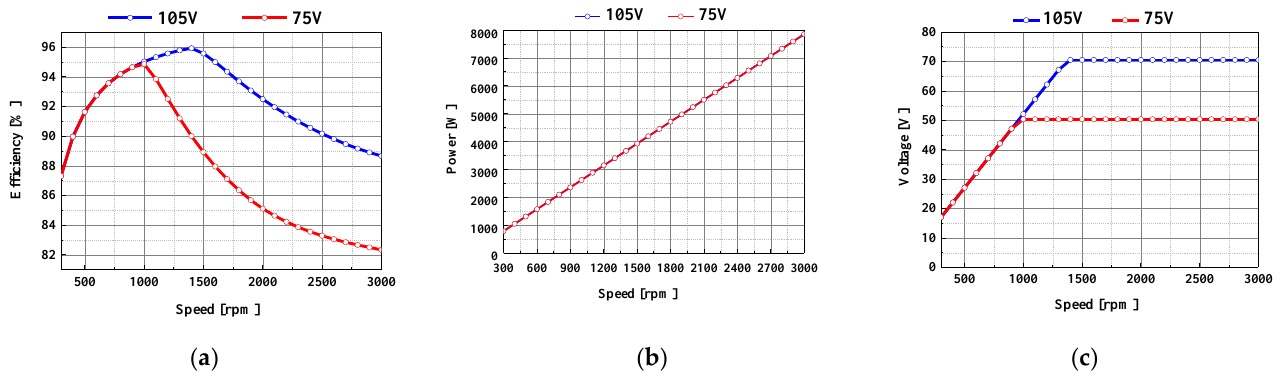
Figure 7. Efficiency and power according to V dclink : ( a ) efficiency, ( b ) power, and ( c ) voltage.